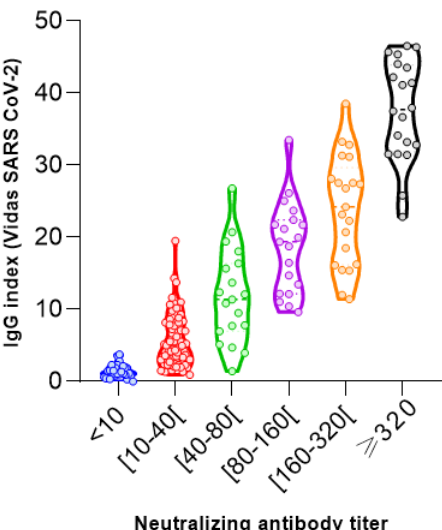
Figure 5. SARS-CoV-2 neutralizing antibody titers correlate with SARS-CoV-2 IgG (VIDAS ® ) (Spearman correlation coefficients ρ = 0.8995 and p -value < 0.0001).